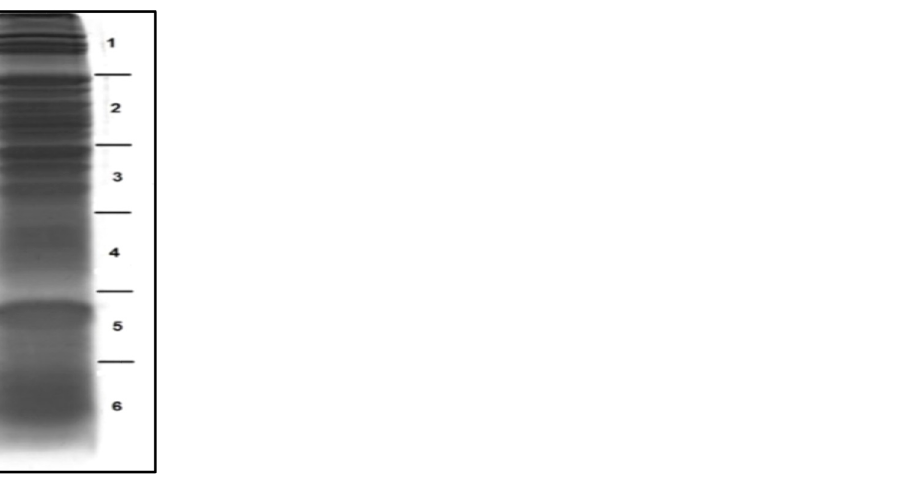
Figure 1. Image of protein separation by SDS–PAGE with scheme of cutting for six gel fragments.